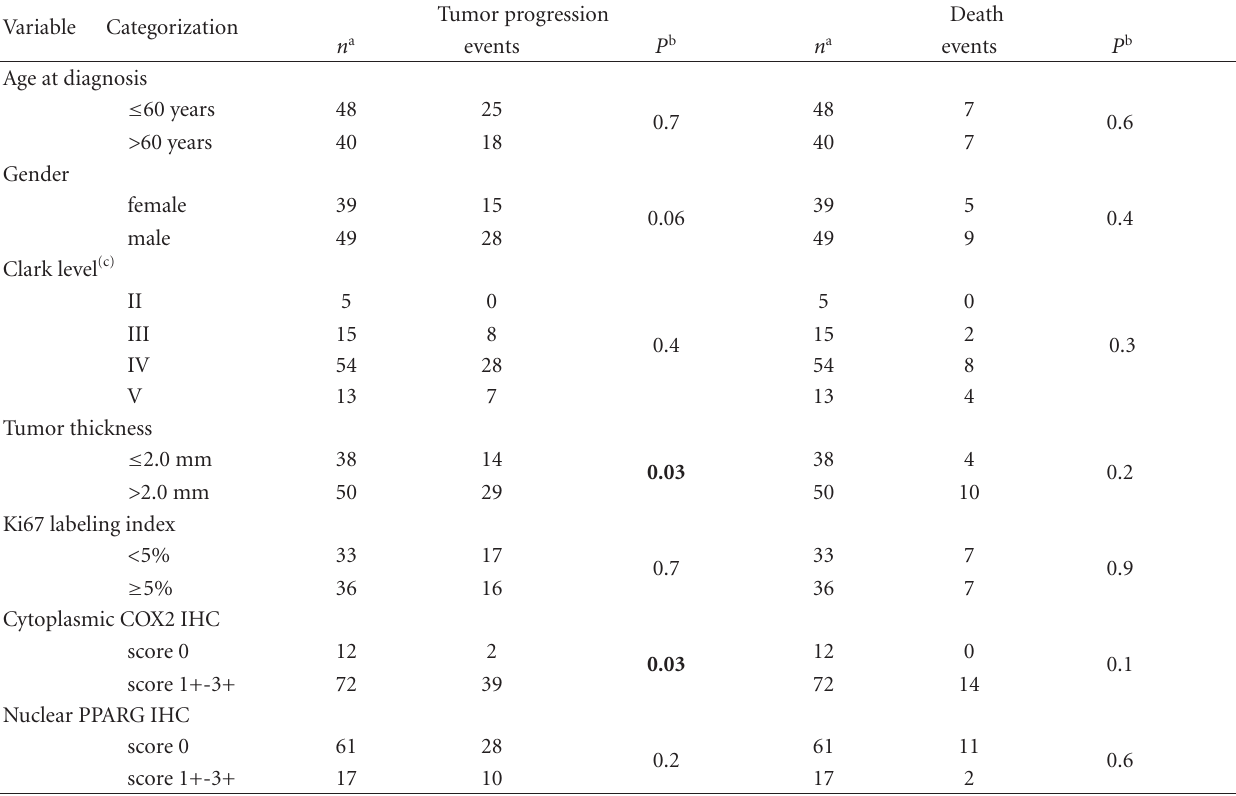
Table 3: Univariate analysis of factors regarding tumor progression and